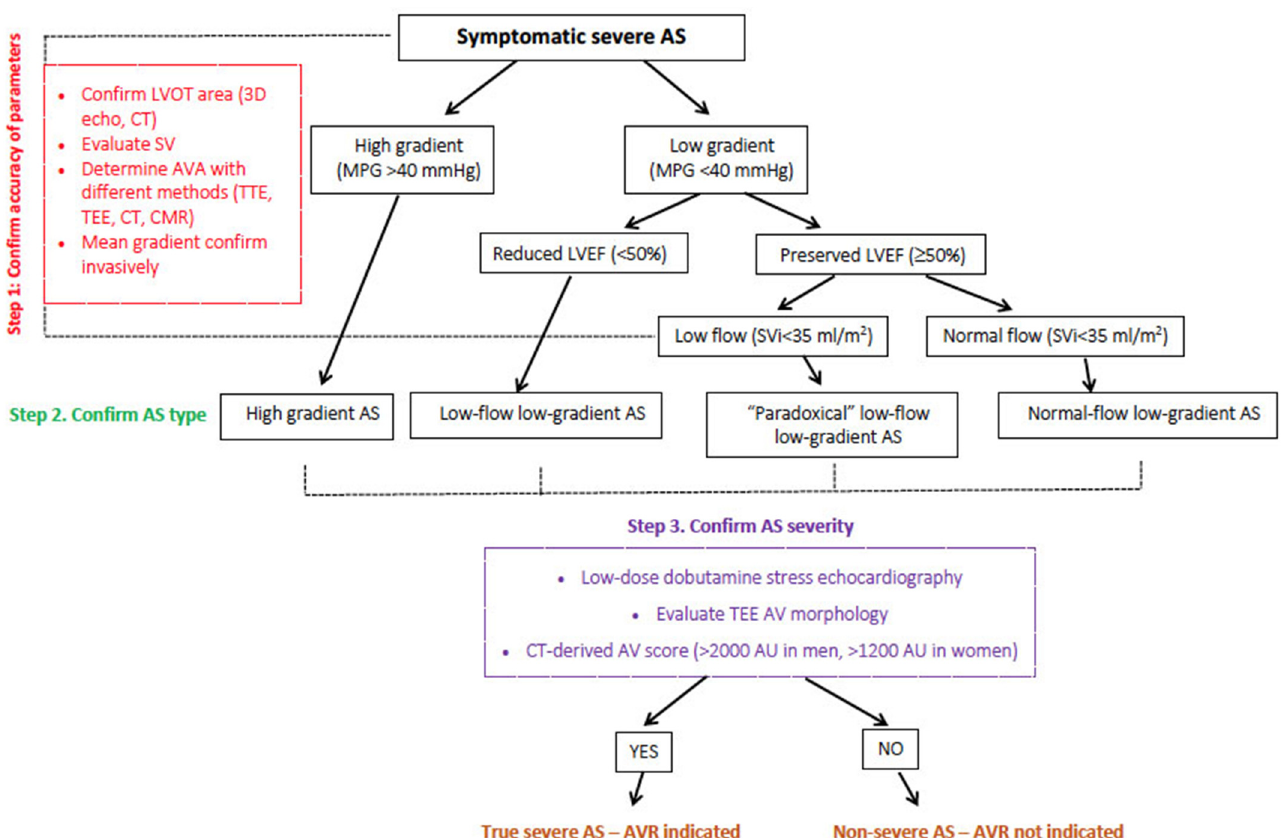
Figure 4. Flowchart for the diagnostic management of AS in patients with heart failure. AS—aortic stenosis, AVA—aortic valve area, LVEF—left ventricular ejection fraction, LVOT—left ventricular